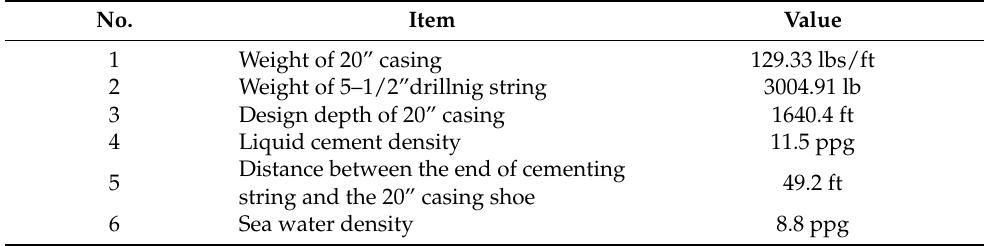
Table 2. Parameters for landed load